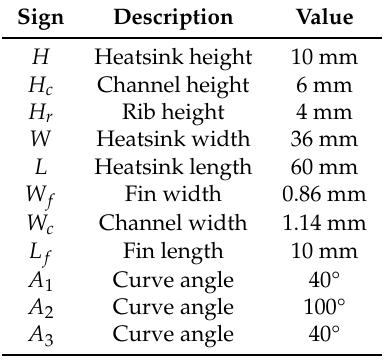
Table 3. Dimensions of the heatsink.